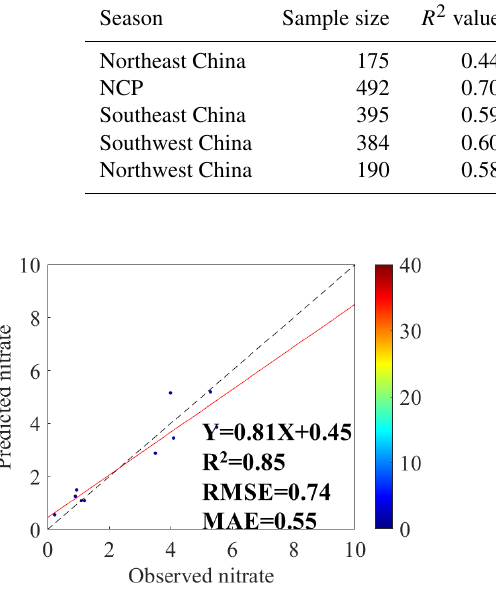
Figure 4. The transferability validation of the ensemble model in estimating NO − concentration over China based on the unlearning 3 observation data (Shen et al., 2009, 2013; W. Wang et al., 2019; Xu et al., 2018b). The colour bar reflects the sampling size of each model. The red solid line denotes the best-fit line through the data points. The black dashed line denotes the diagonal, which could be used to reflect the deviation of data